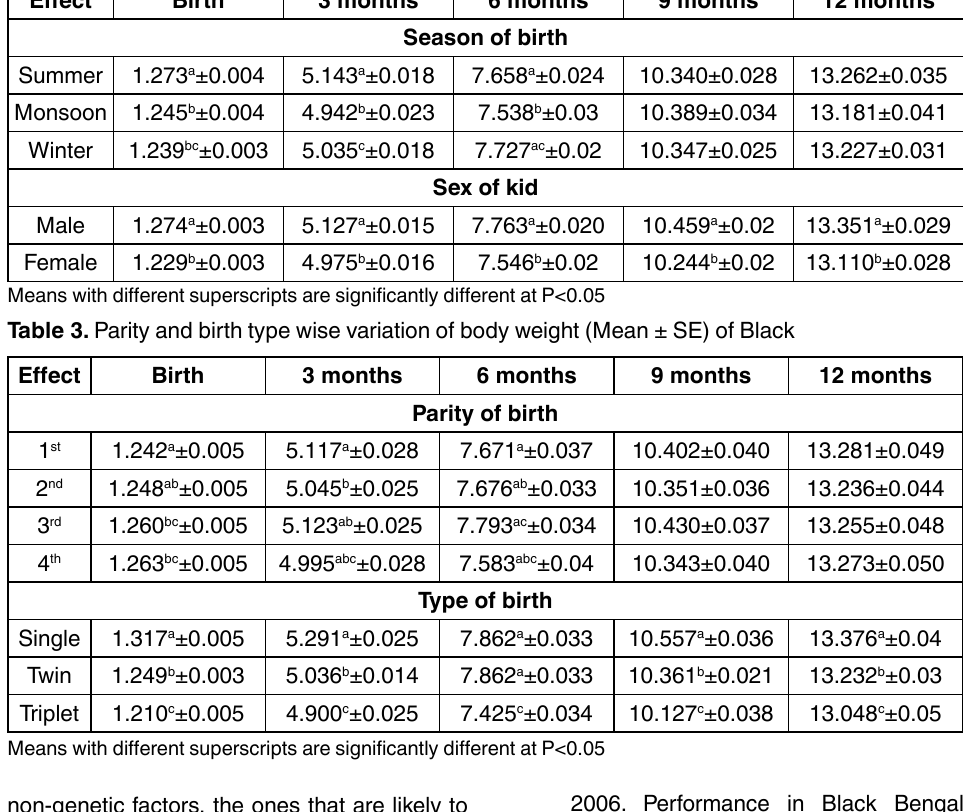
Table 2. Season and sex wise variation of body weight (Mean ± SE) of Black Bengal Goat